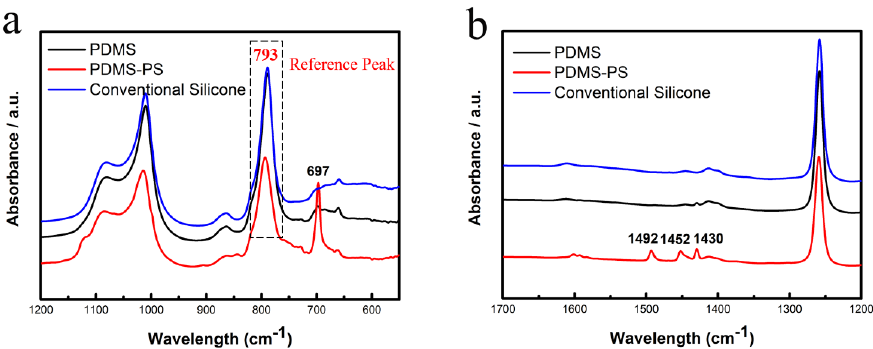
Figure 5. Fourier transform infrared (FT-IR) spectra of the PDMS-PS, PDMS and conventional silicone. ( a ) Infrared spectrum wavelength is 1200~550 cm − 1 ; ( b ) Infrared spectrum wavelength is 1700~1200 cm − 1 .